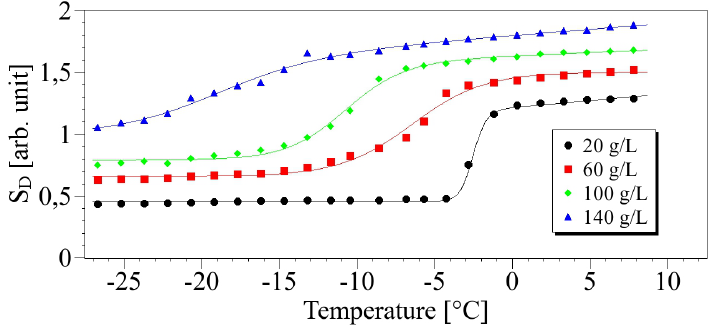
Figure 9. Experimental validation of the method: the curves are plots from Equation